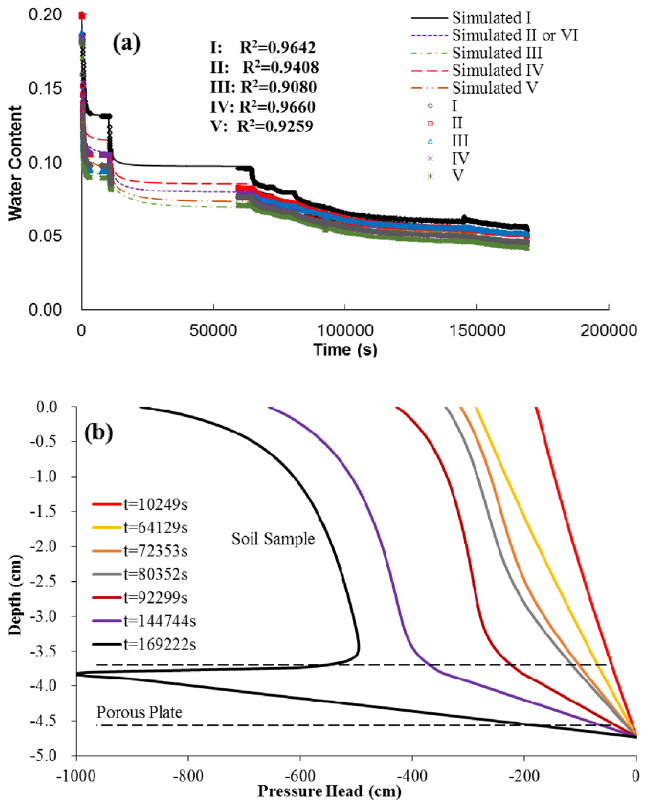
Figure 7. ( a ) Predicted water content changing at five different depths by the numerical model versus data (points) observed by Šimůnek and Nimmo 15 for Run 1, where I–VI represent the assumed locations for water content measurements in Šimůnek and Nimmo 15 . The coefficients of determination (R 2 ) for all the comparisons are also listed in the figure, and ( b ) simulated pressure heads profiles at times when the rotation speed was